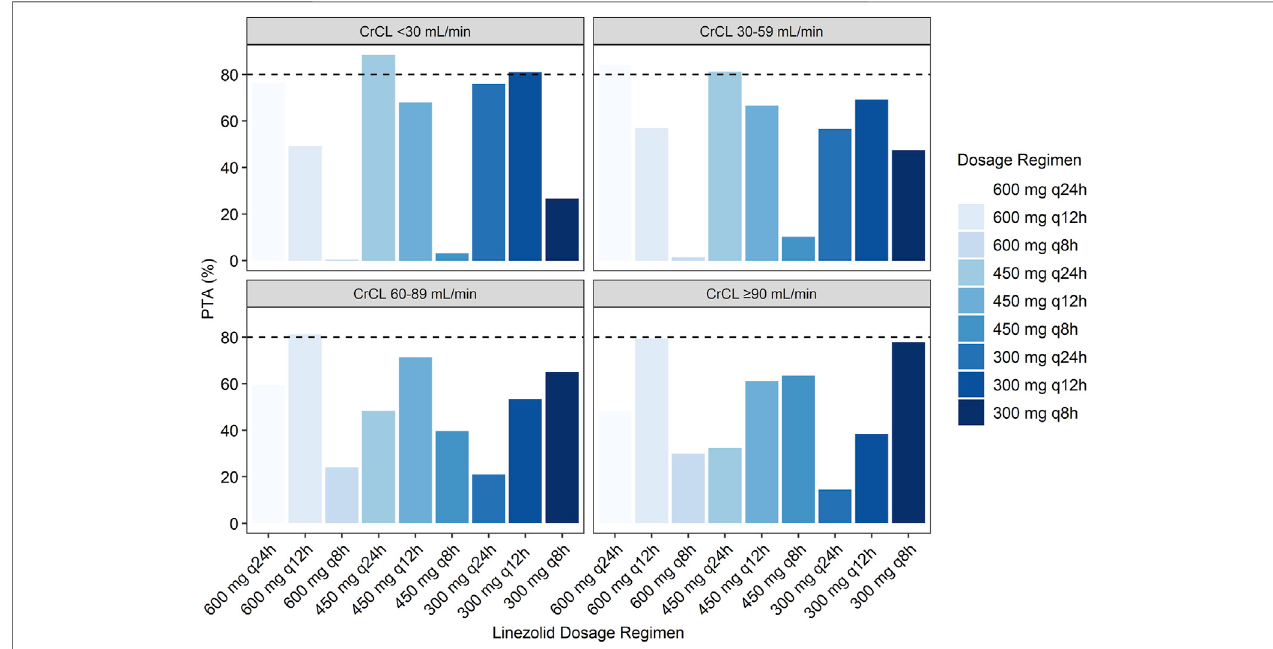
FIGURE 4 | Simulated probability of achieving target attainment of linezolid (C min : 2.6 – 7.8 mg/L) strati fi ed by renal function.